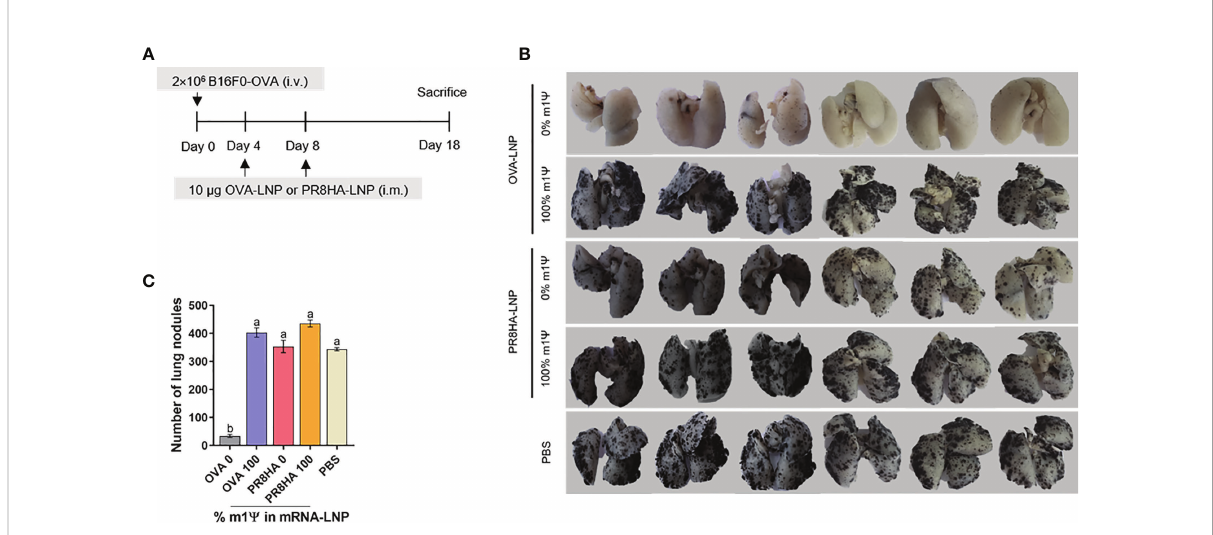
FIGURE 7 Immunization of unmodi fi ed mRNA-LNP inhibits lung metastasis of B16F0-OVA melanoma. (A) Schematic immunization schedule for melanoma metastatic model. See methods for details. (B) The lungs were observed and (C) the metastatic nodules on the surface of the lungs were counted. The results are presented as the mean ± SEM of biologically independent mice ( n = 6) per group. Statistical signi fi cance by one- way ANOVA with Bonferroni multiple comparisons test when p < 0.05 compared to the unmodi fi ed target antigen: a, control: